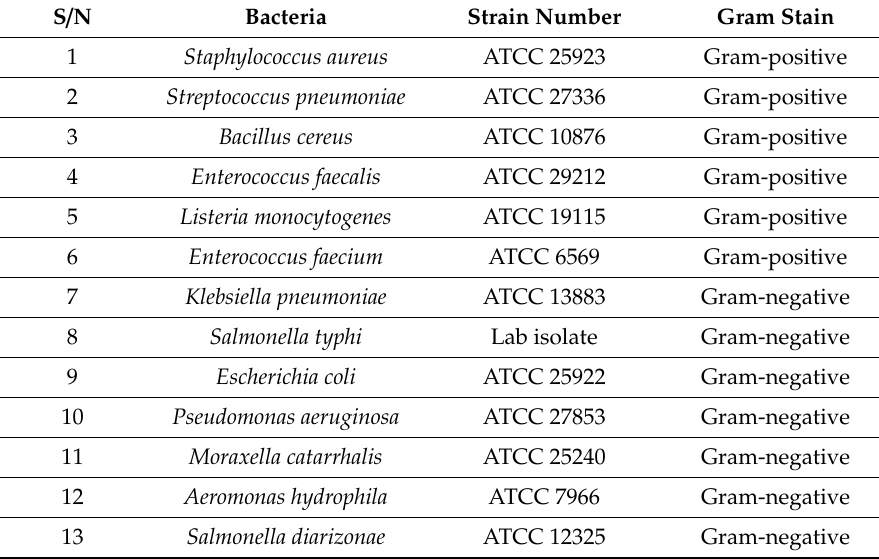
Table 1. List of bacterial